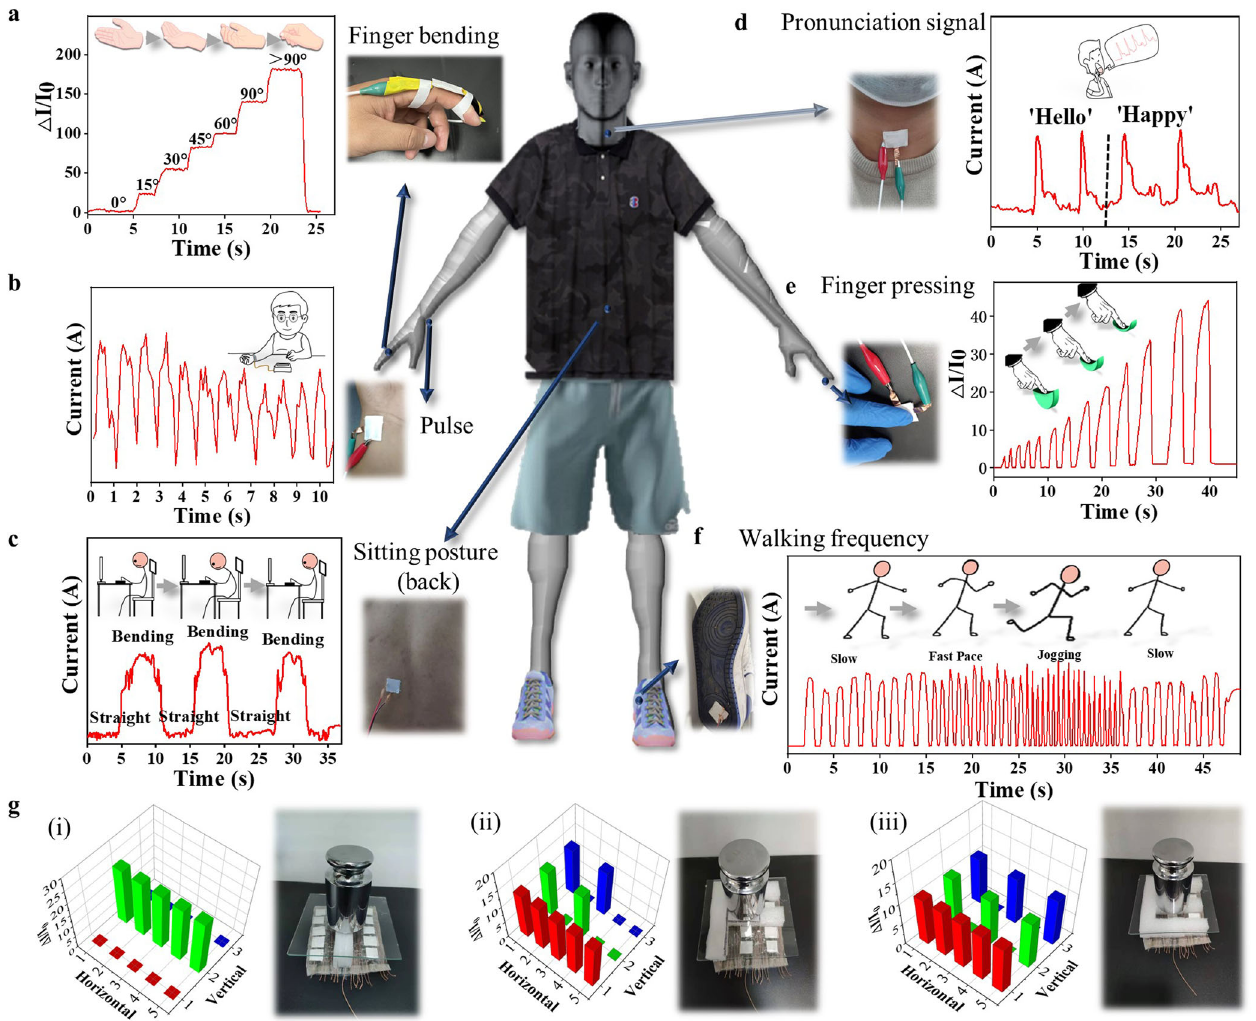
Fig. 4 Application in real-time monitoring of human physiological signals. a The real-time response of the sensor fi xed on the index fi nger at different bending angles. The photo is an optical image of the sensor worn on a fi nger. b The pulse on the wrist measured by the sensor at a rate of 72 beats per minute. The photo is an optical image of the sensor worn on the wrist. c The real-time response of the sensor fi xed on the back of the human body in different sitting positions. The photo is an optical image of the sensor attached to the back. d Response curves of the sensor mounted on the throat to monitor voice pronunciation. The photo is an optical image of the sensor worn on the throat. e The real-time response of the sensor during fi nger pressing. The photo is an optical image of the sensor under fi nger pressing. f Real-time response of the sensor mounted on a foot at different walking frequencies. The photo is an optical image of the sensor attached to a shoe. g The sensing array response mapping of the pressure distributions corresponding to different shapes of ‘ I ’ (i), ‘ F ’ (ii), and ‘ E ’ (iii) and their optical